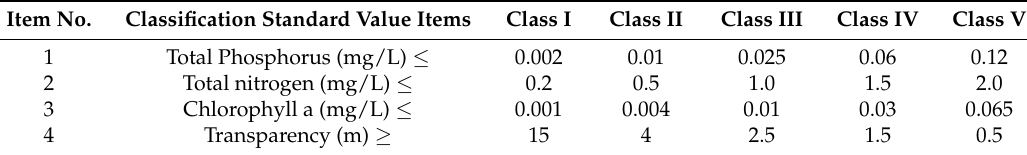
Table 2. Standard values of specific items for lakes and reservoirs [41].